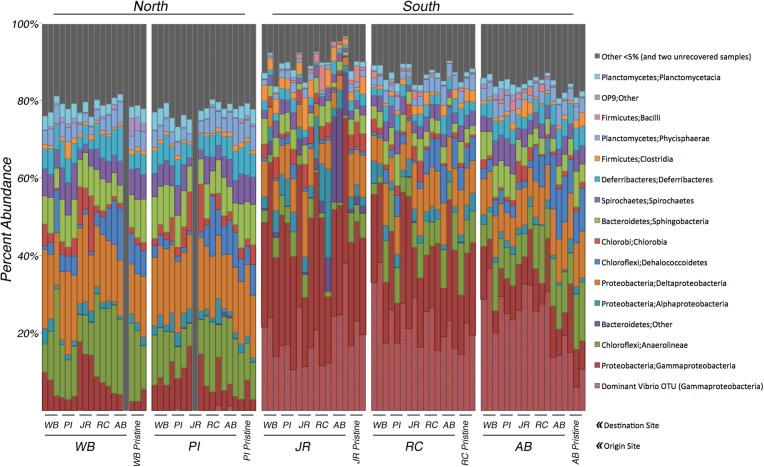
Relative abundance of bacterial 16S rRNA genes among transplant samples and controls.Taxonomic assignments for bacterial 16S rRNA genes were based on 97% sequence similarity. Only taxa that occur in ≥5% abundance in any individual sample are colored. Blocks of samples are arranged by origin site (north to south), and by destination site within each block. The last three columns in each block are the pristine controls. The hatched columns are the Vibrio sp. subset of Gammaproteobacteria. Grey columns represent all taxa <5% abundance and two samples that did not amplify.